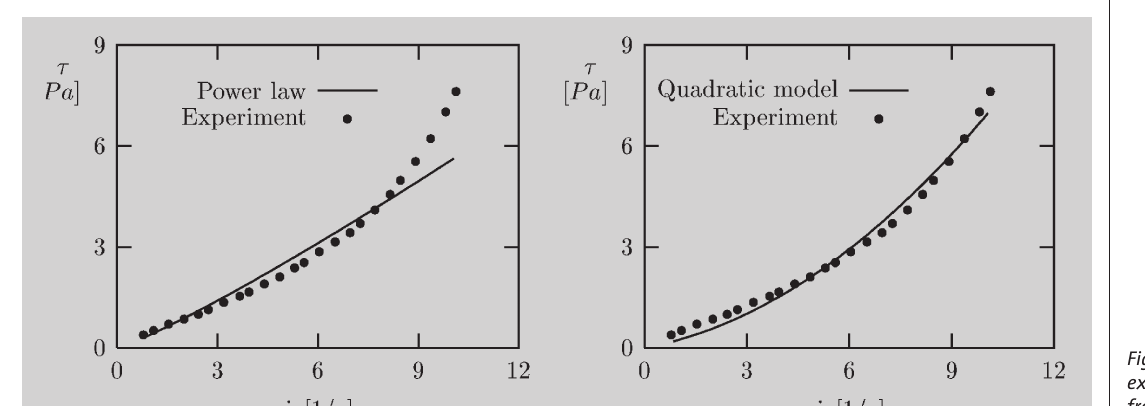
Figure 2: Comparison of experimental data taken from Steffe and rheological